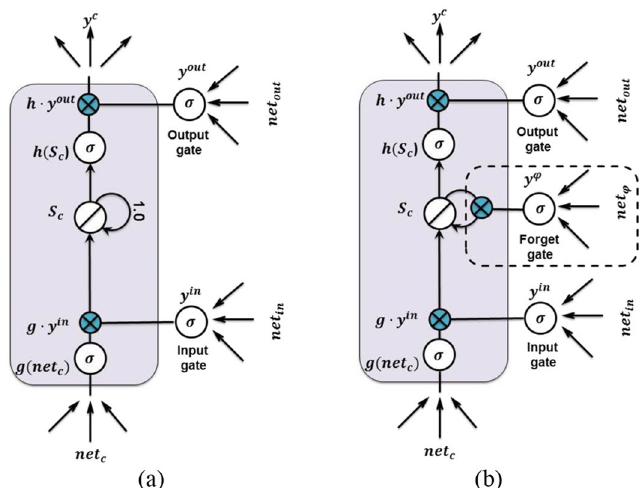
Fig. 16 a Original LSTM cell architecture; b LSTM cell includes forget gate [101]